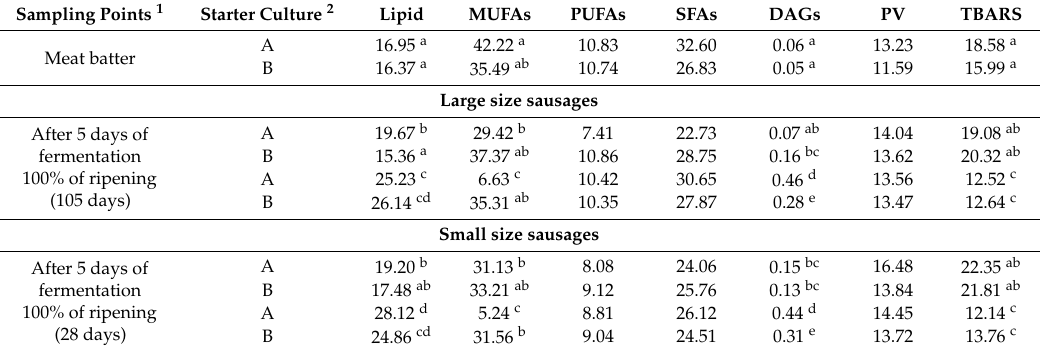
(meq O 2 /kg fat), and TBARS (mg MDA/kg sample) of the samples during fermentation and